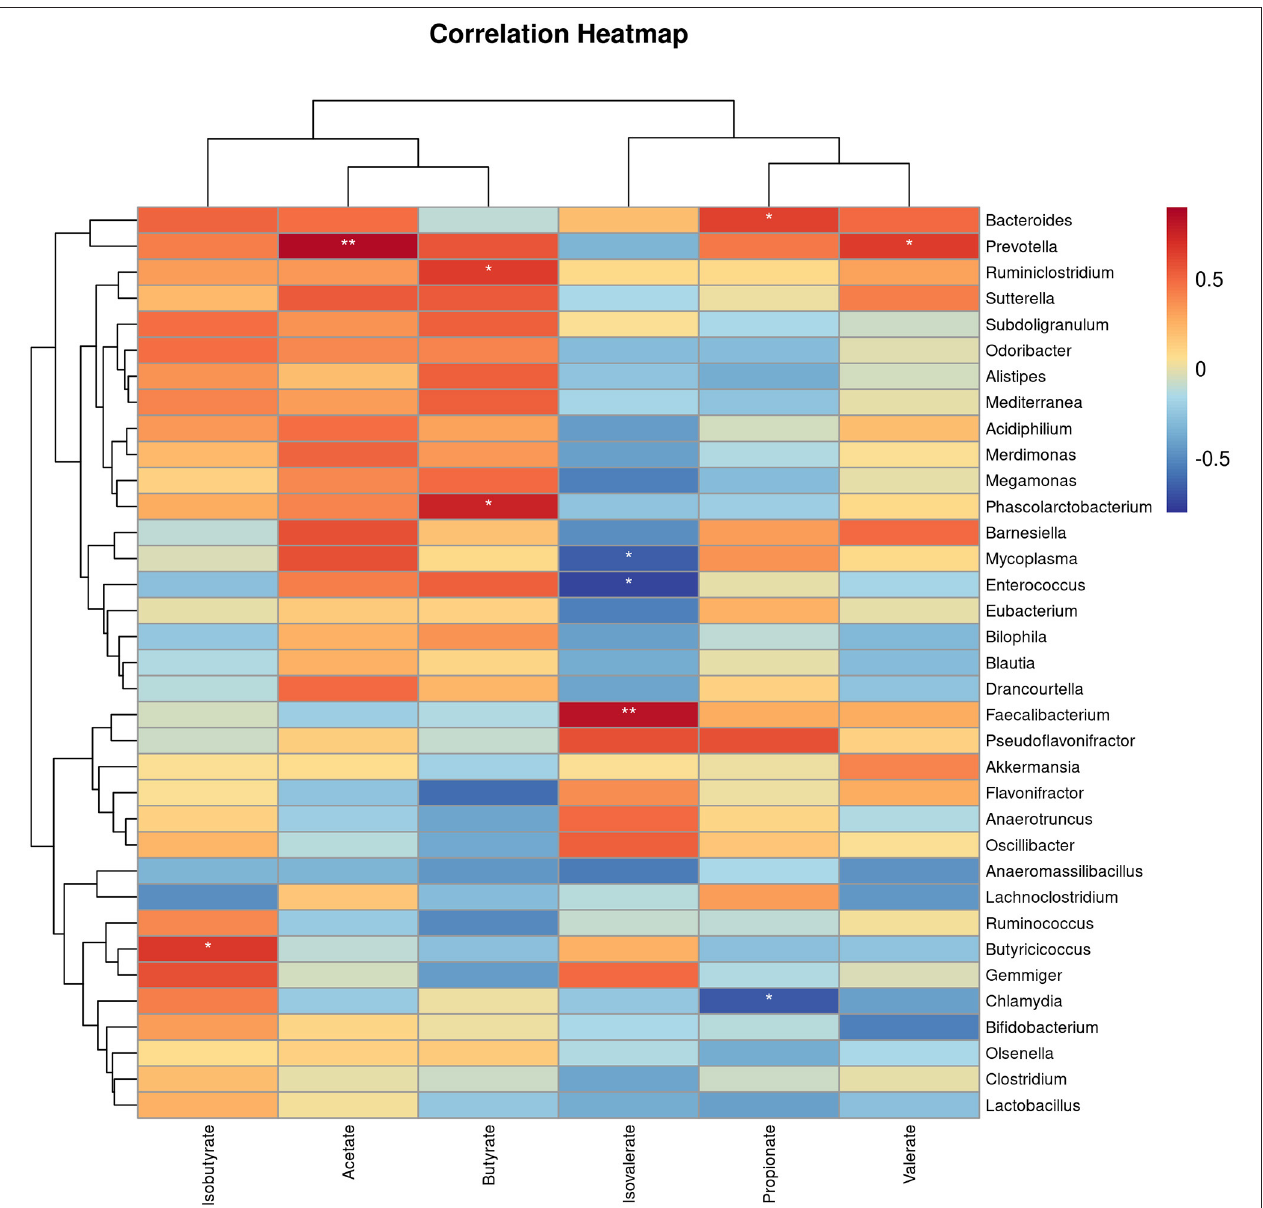
FIGURE 8 | The heat map represents the correlation between caecal SCFAs and caecal microbiota in EP and control group broiler chickens. * P < 0.05 and ** P < 0.01, respectively.